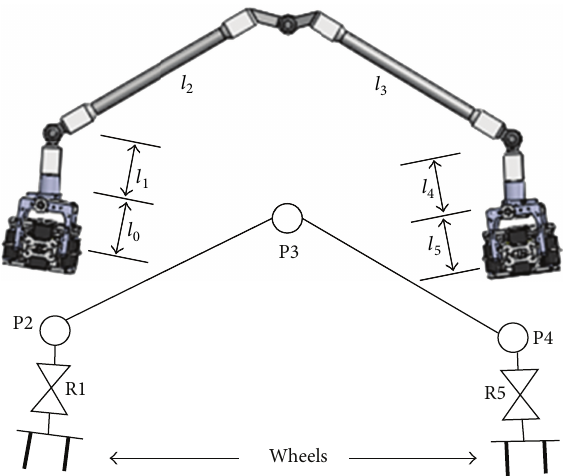
Figure 5: The joint configuration of the manipulator.